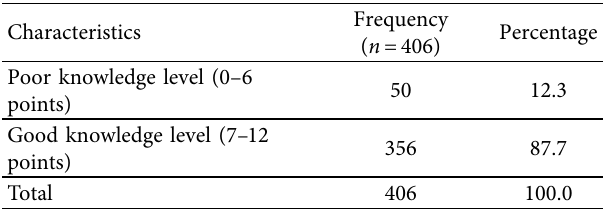
Table 3: Adolescent school girls’ knowledge grading on men- struation and its